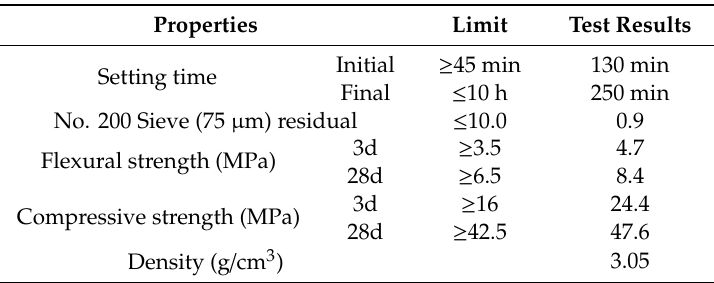
Table 2. Physical properties of cement.